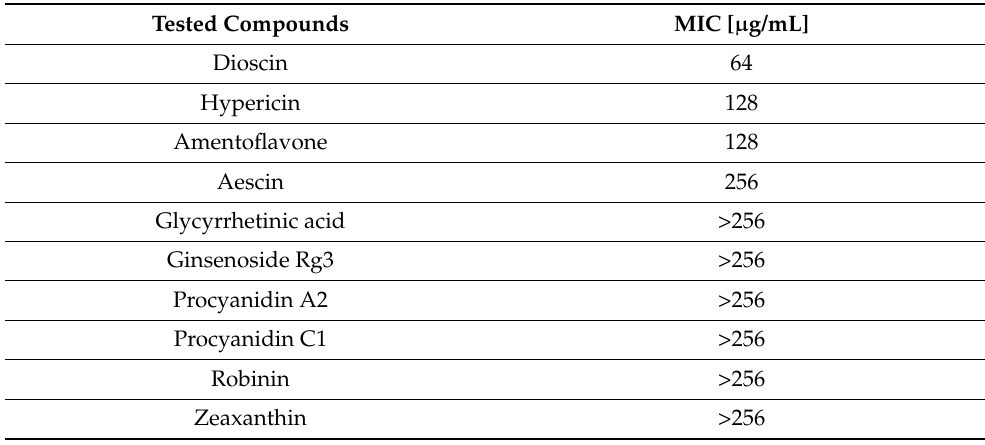
Table 2. Minimal inhibitory concentration (MIC) values of 10 selected compounds of natural origin against H. pylori